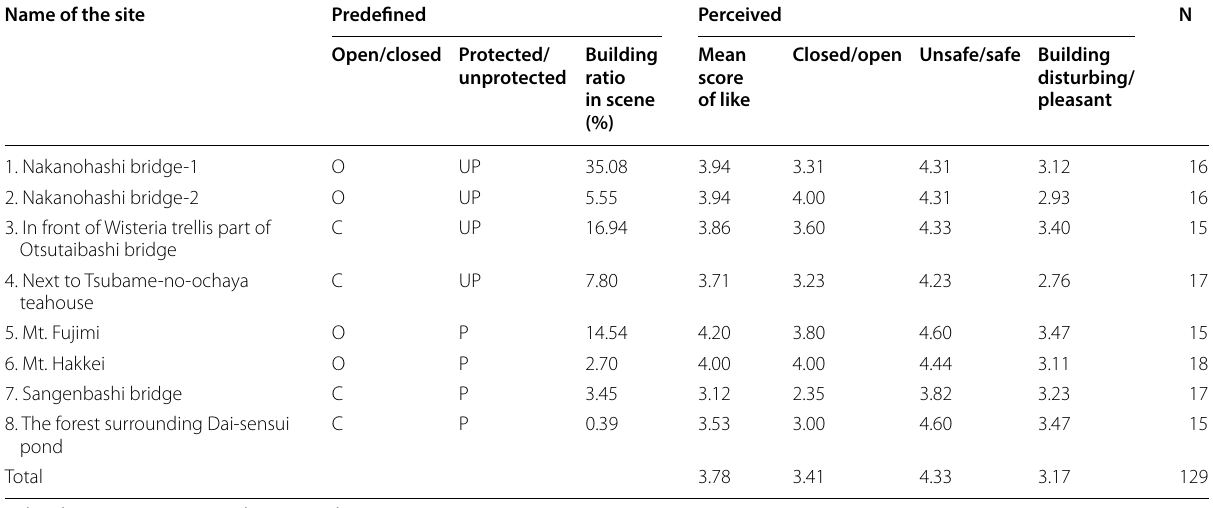
C closed, O open, UP unprotected, P protected